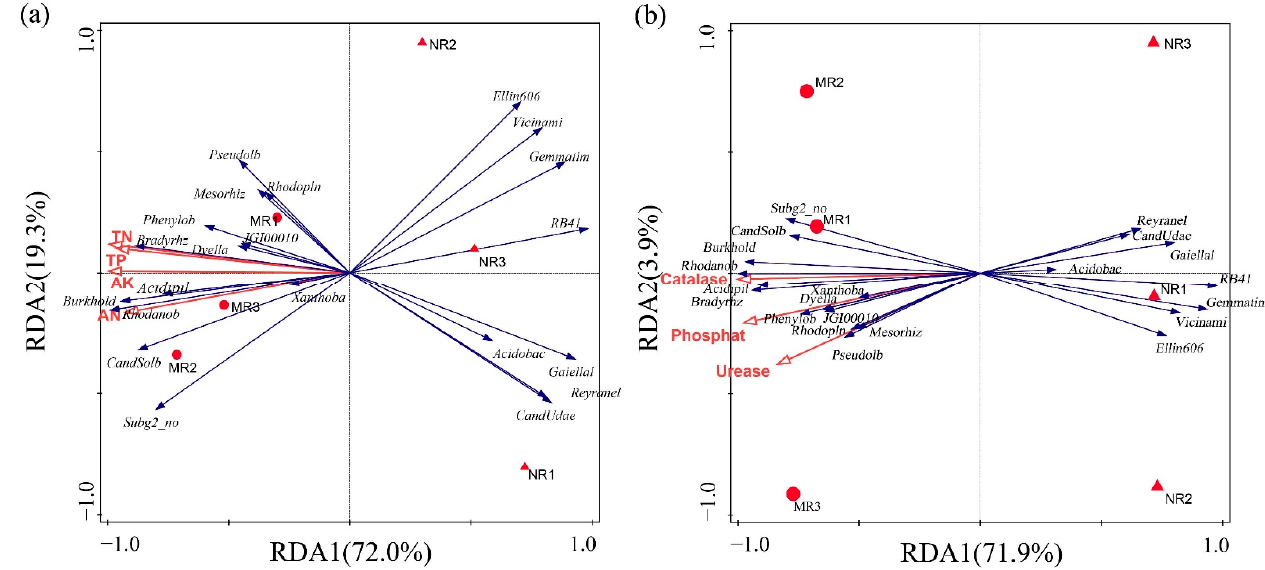
Figure 7. ( a ) Redundancy analysis among dominant bacterial genera (>1%) and soil physicochemical